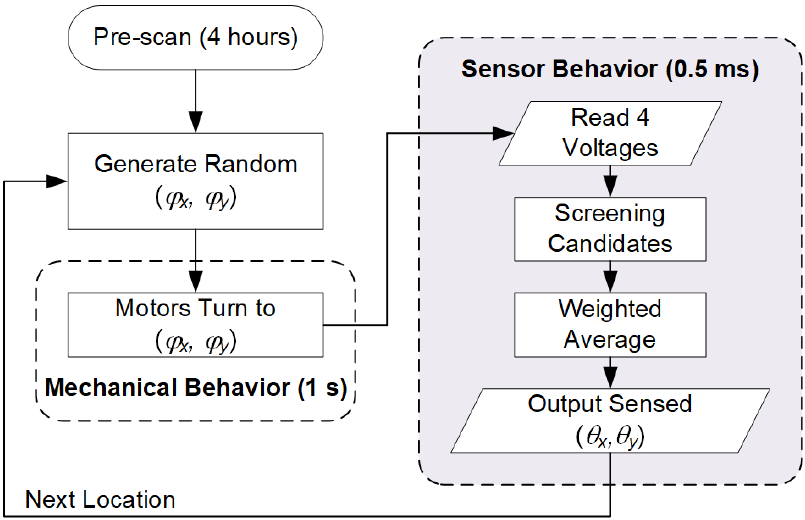
Figure 10. The flow chart for testing the proposed